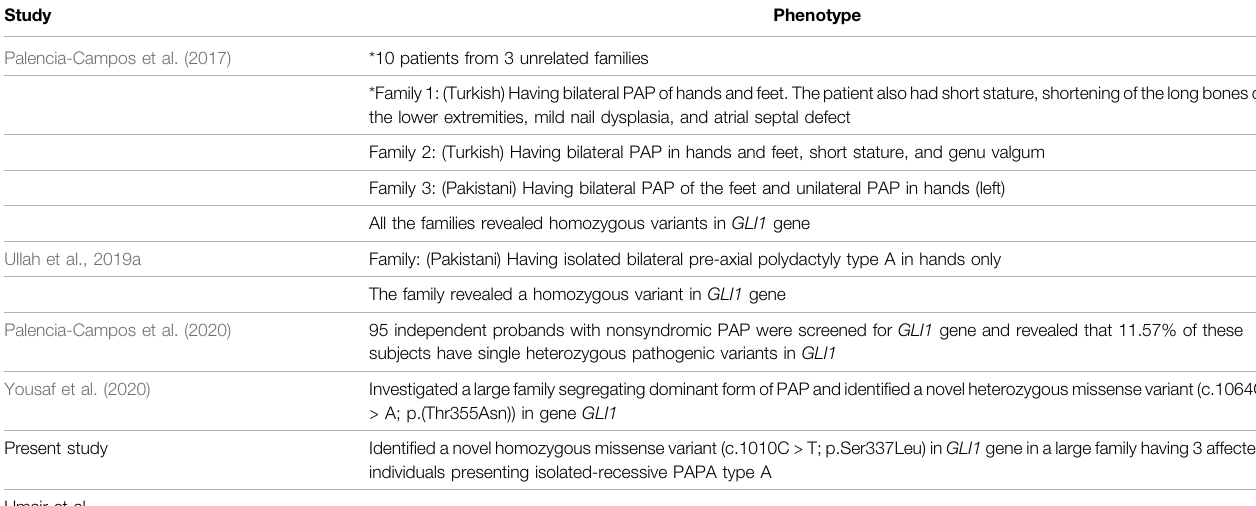
TABLE 2 | Clinical description of PAPA8-associated phenotypes as compared with the patients presented in the present study.